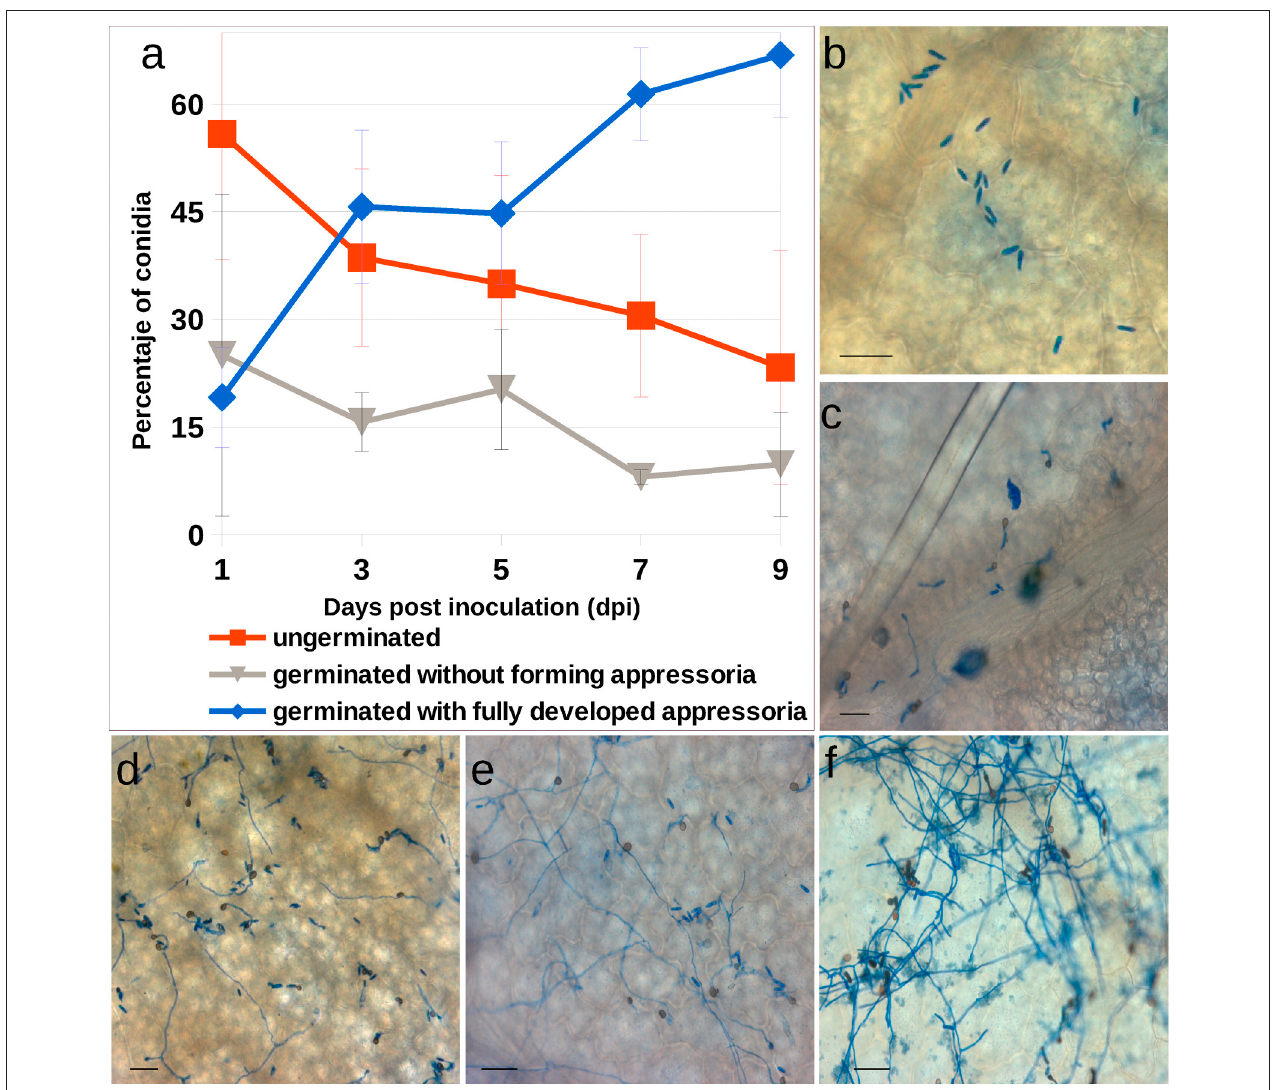
FIGURE 1 | Colletotrichum acutatum development in strawberry tissue. (A) Progression of C. acutatum isolate CECT 20240 conidial germination. (B–F) Photomicrographs of C. acutatum structures formed during infection of strawberry leaves over a 9-days period. (B) Non germinated conidia at 1 dpi; (C) Germinated conidia after 3 dpi; (D,E) Appressorium and mycelium development at 5 and 7 dpi, respectively; (F) Abundant mycelium at 9 dpi. All bars 25 µ